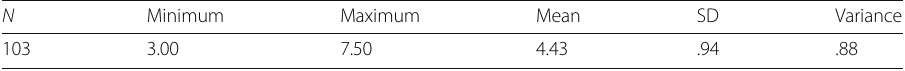
Table 2 Descriptive statistics of teachers ’ letter writing task